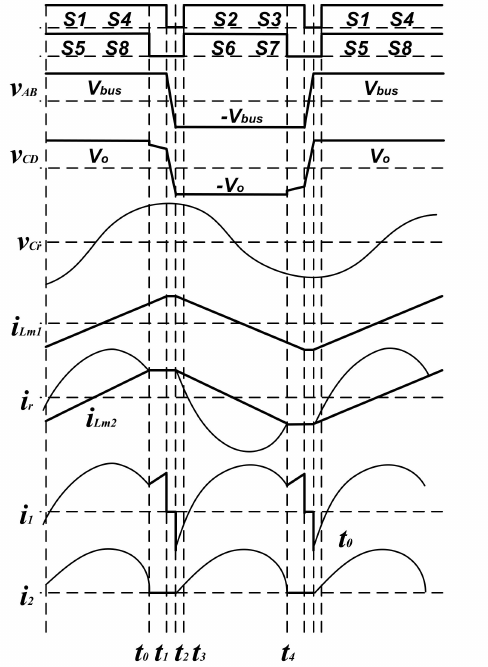
Figure 3. The theoretical waveform at switching frequency below the resonant